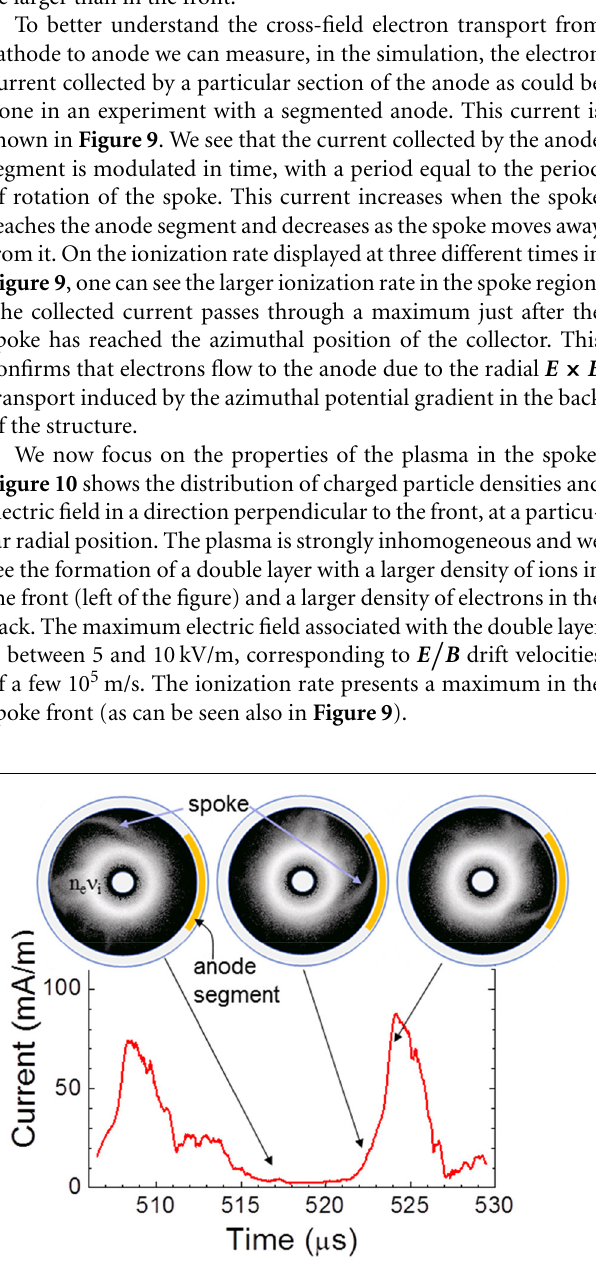
FIGURE 9 | Electron current as function of time collected by a segment of the anode (indicated by an orange line on the right side of the anode). The distribution of the ionization rate (integrated over 200 ns) is also displayed at three different times (log scale, three decades, maximum 10 22 m − 3 s − 1 , darker regions corresponds to lower ionization rates). The positions of the spoke front at the three times can be seen on the ionization rate